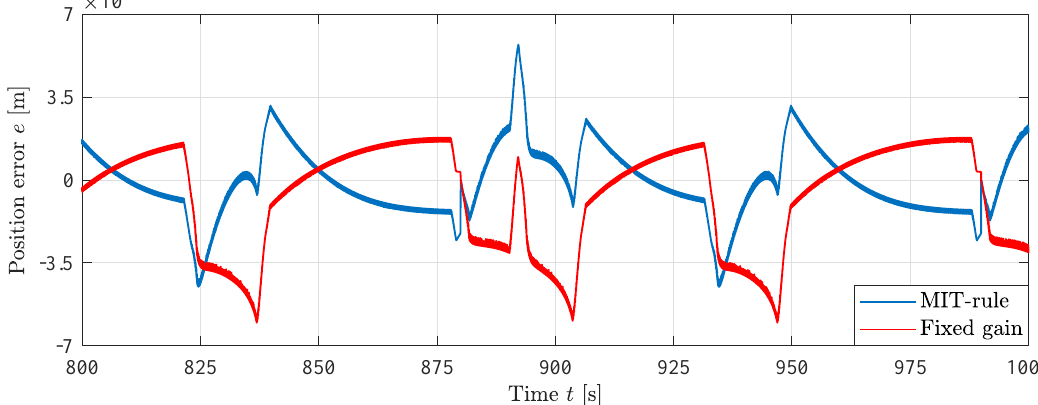
Figure 21. Position error comparison between MIT-rule and fixed gain feedforward in simulation.